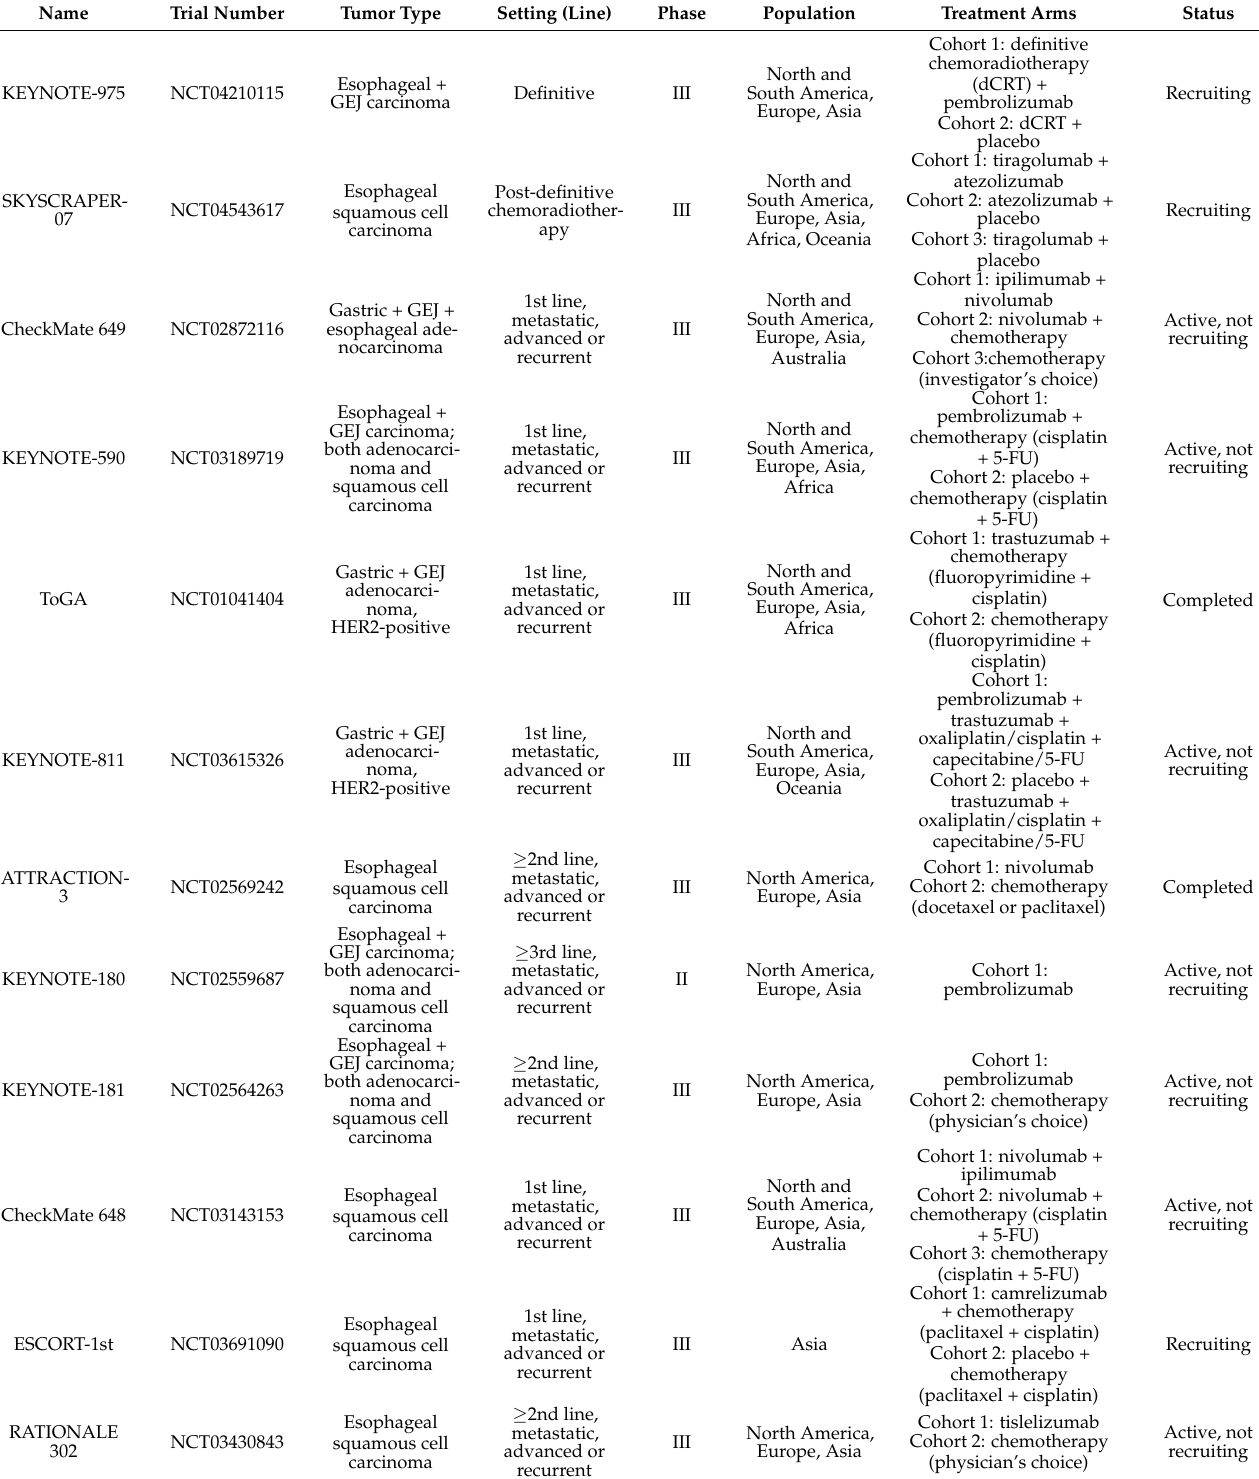
Table 2. Overview of recent clinical trials discussed in this review in patients with unresectable or metastatic esophageal